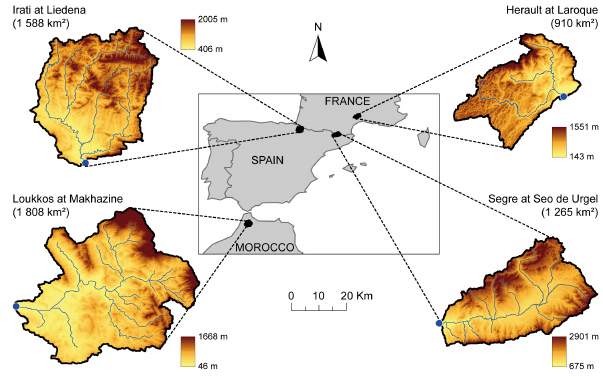
Figure 1. Studied basins: location in the Western Mediterranean and